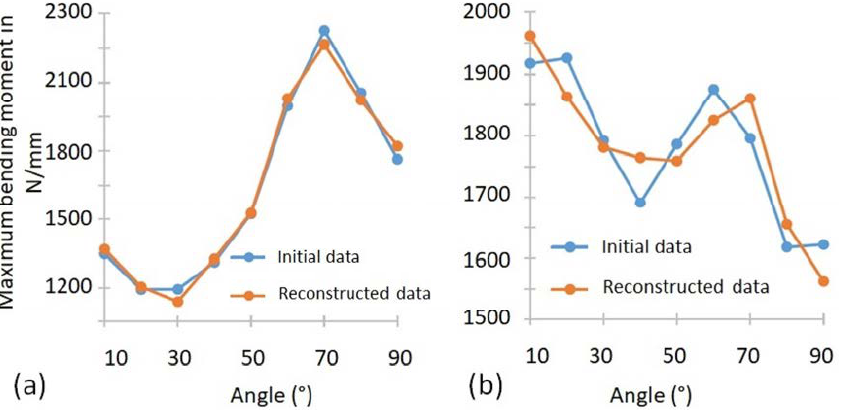
Figure 10. Reconstruction of the initial measurement from the 4 main eigenmodes identified for ( a ) the hand H1 and ( b ) the hand